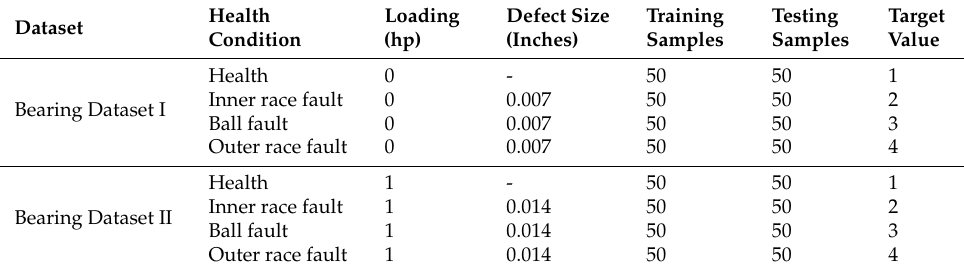
Table 1. Description of the bearing fault